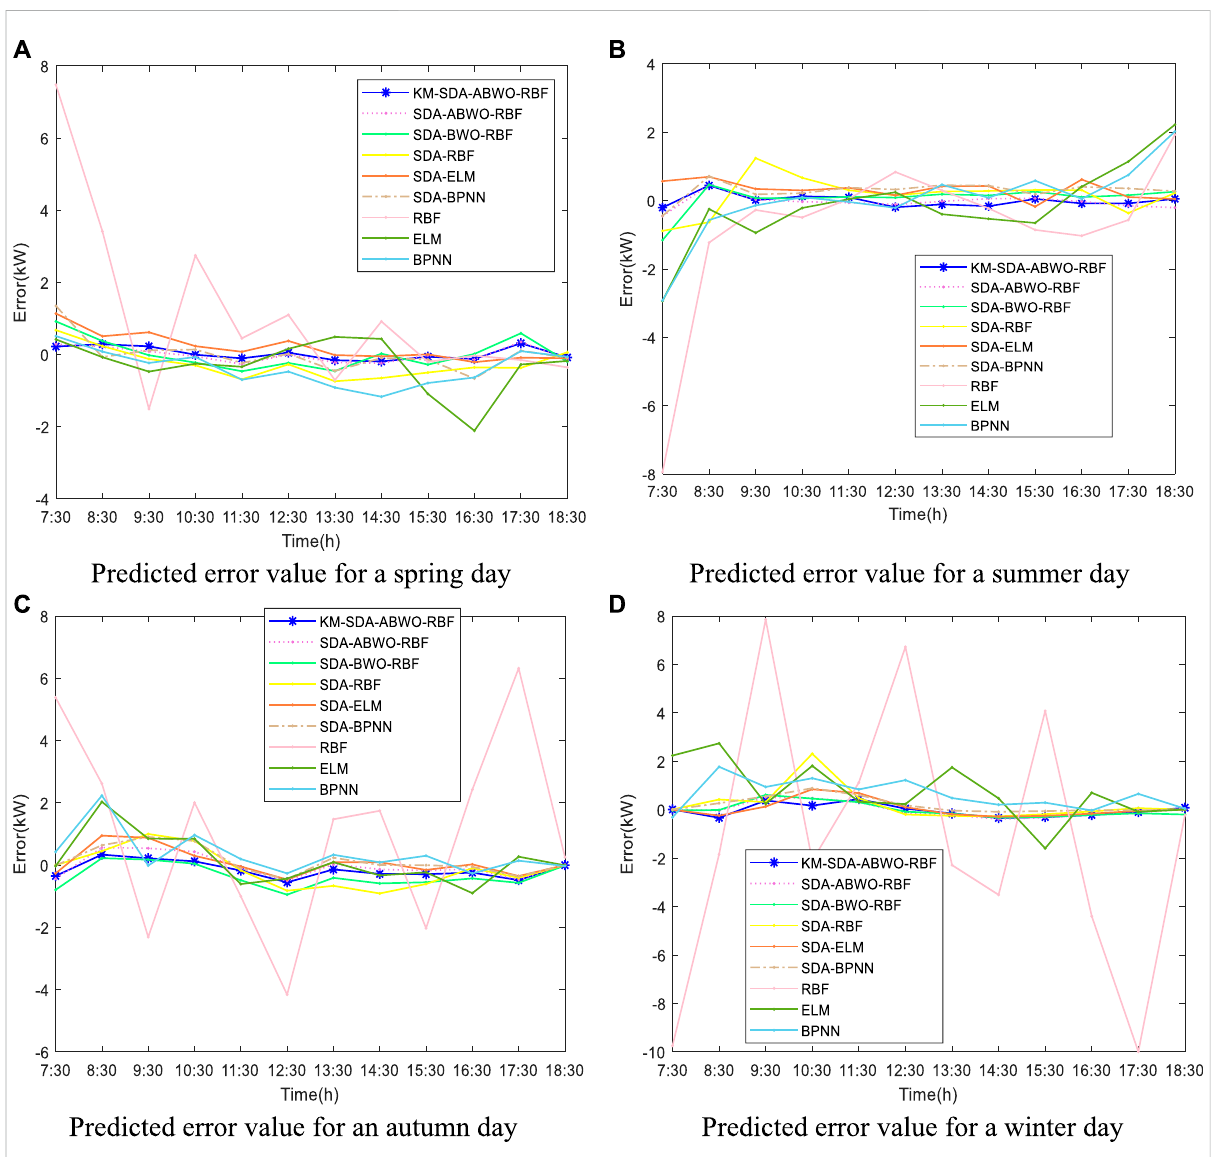
FIGURE 7 Predicted error value. (A) A spring